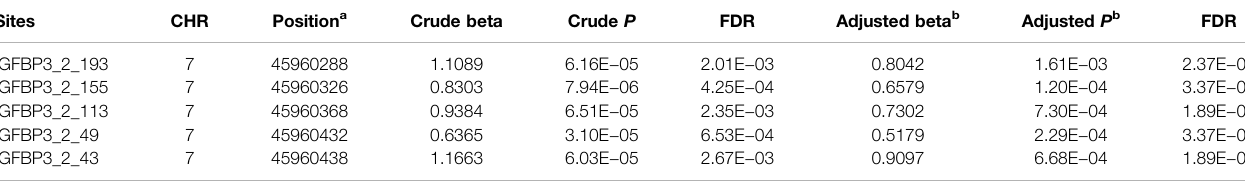
TABLE 2 | Signi fi cant associations between IGFBP3 methylation and DBP.